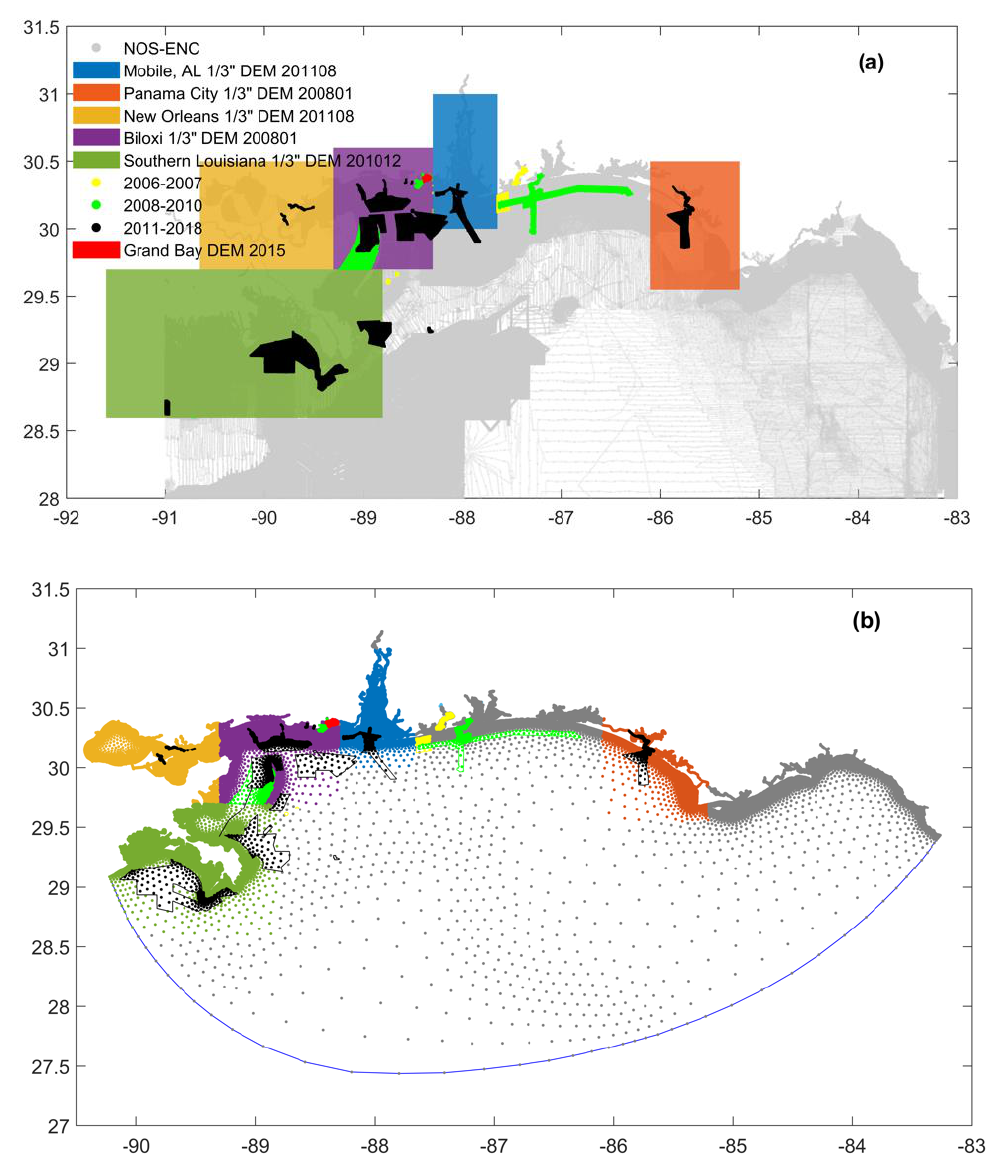
Figure 2. ( a ) Major bathymetry data sources overview. Data priority is based on survey date. The more recent data, the higher data priority. ( b ) Bathymetry data sources at mesh nodes. Table 1. Bathymetry data source overview.